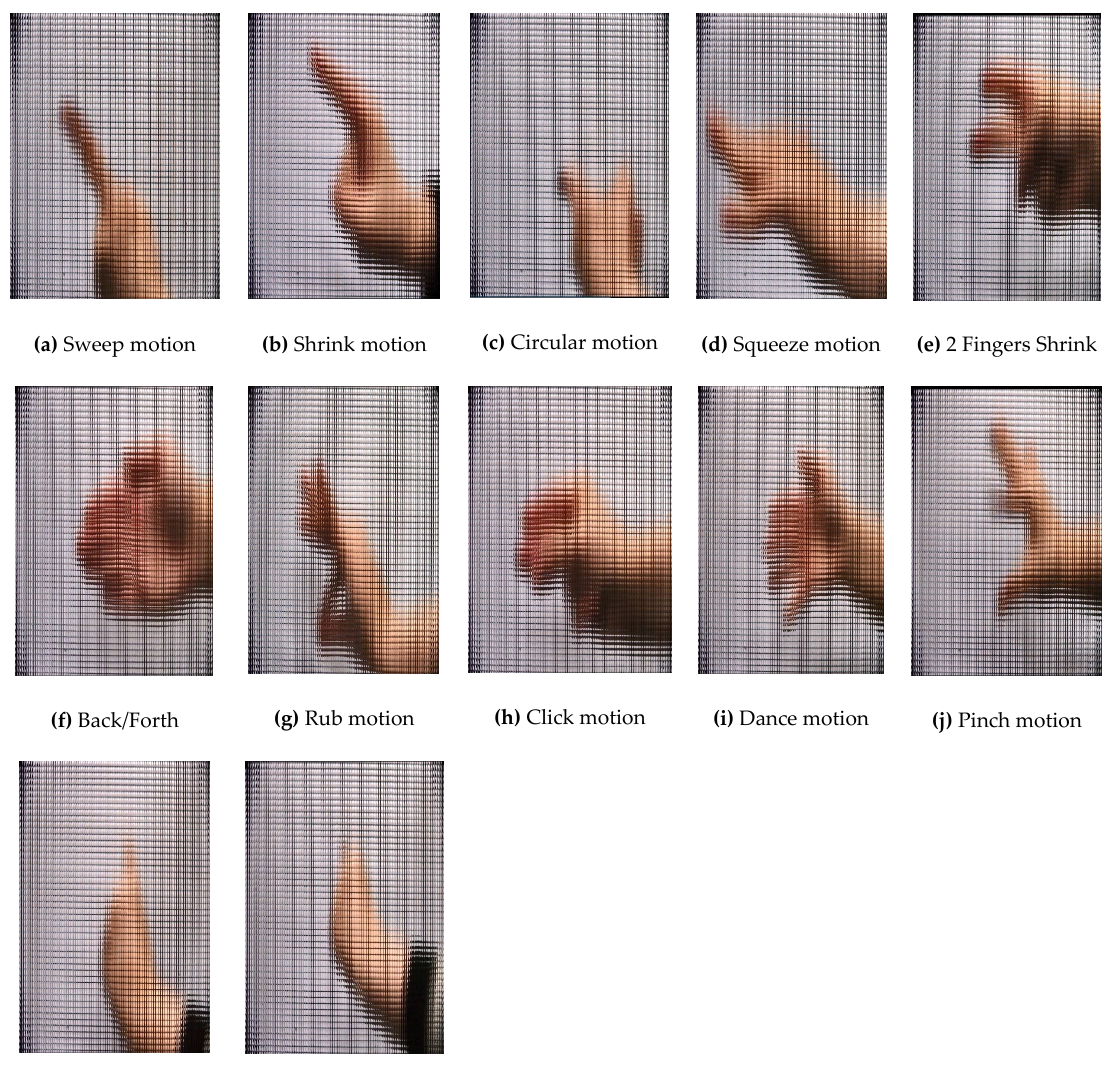
Figure 6. Pre-extraction for first subject’s 3D micro hand motions.